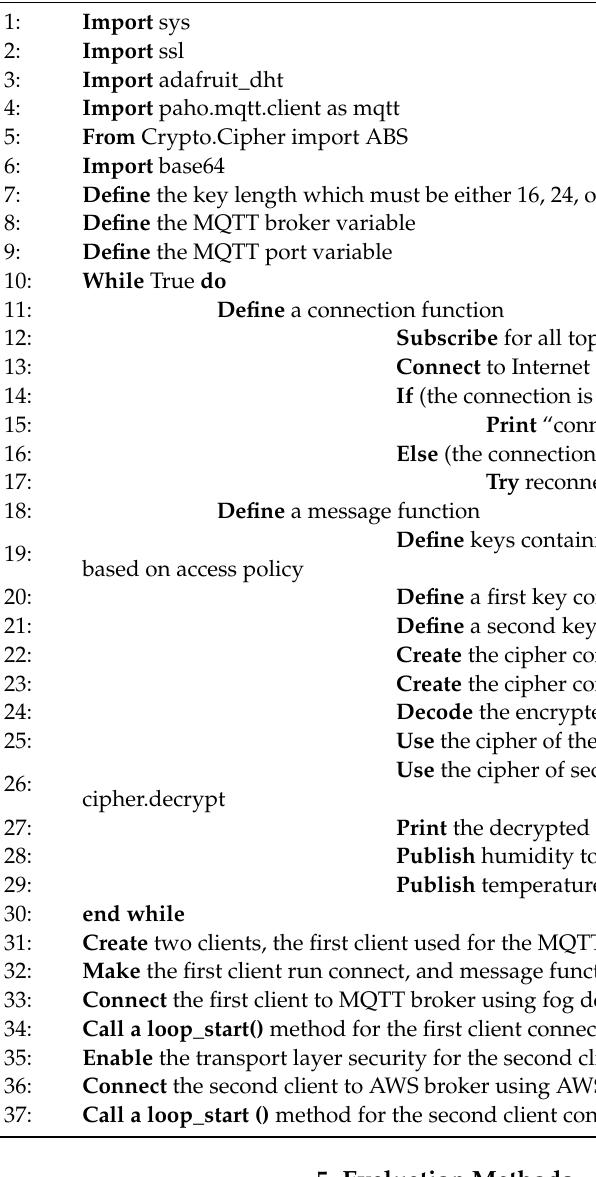
Algorithm 2: Collect data received from the fog device and send it to the cloud–IoT–Fog–Cloud architecture. This algorithm provides authentication and authorization operations from fog devices to IoT devices (DHT11 sensor + Raspberry Pi) and from fog devices to the AWS